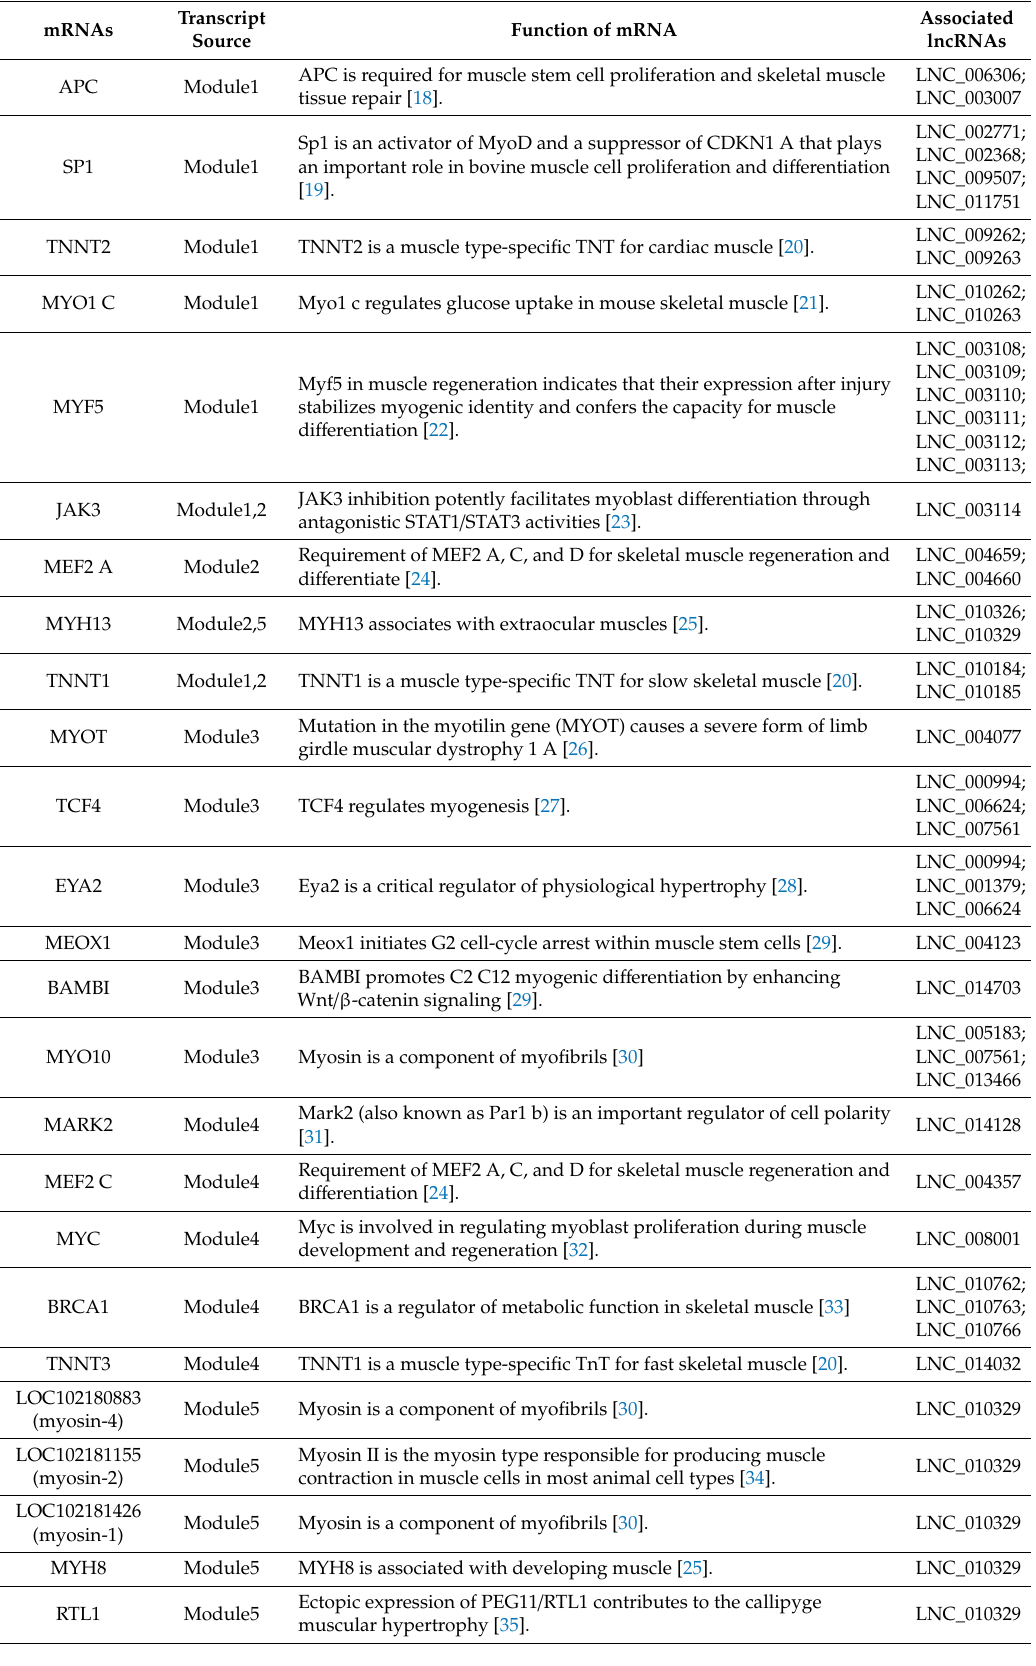
Table 1. Five muscle-related targeting mRNAs of goat skeletal muscle LncRNAs in each